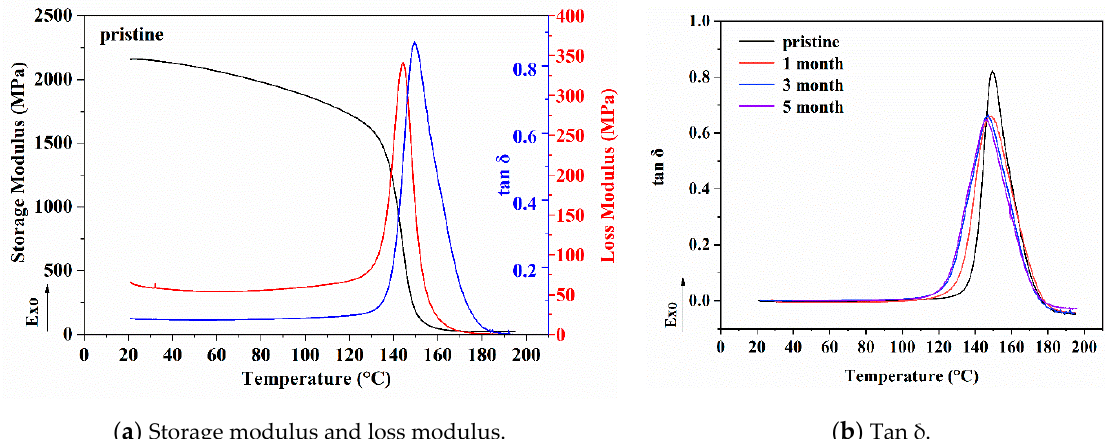
Figure 7. Variation of storage modulus, loss modulus of control, and tan δ of epoxy resin specimens immersed in the 60 °C alkali solution with the immersion time of ( a ) storage modulus, loss modulus of control, and ( b ) tan δ of immersed samples.